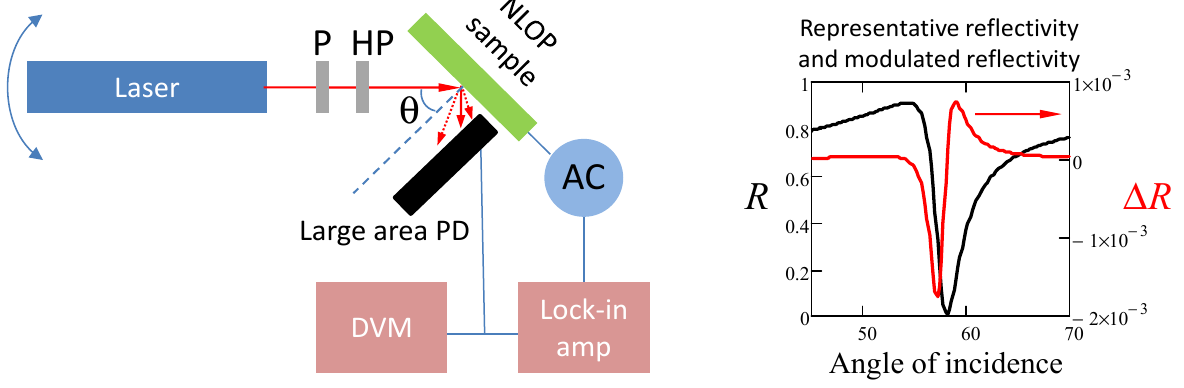
Figure 1. Schematic of Fabry-Perot (FP) experimental setup ( left ) and representative reflectivity R and modulated reflectivity Δ R from digital voltmeter (DVM) and lock-in amplifier, respectively ( right ). P, HP, PD, and AC are polarizer, half wave